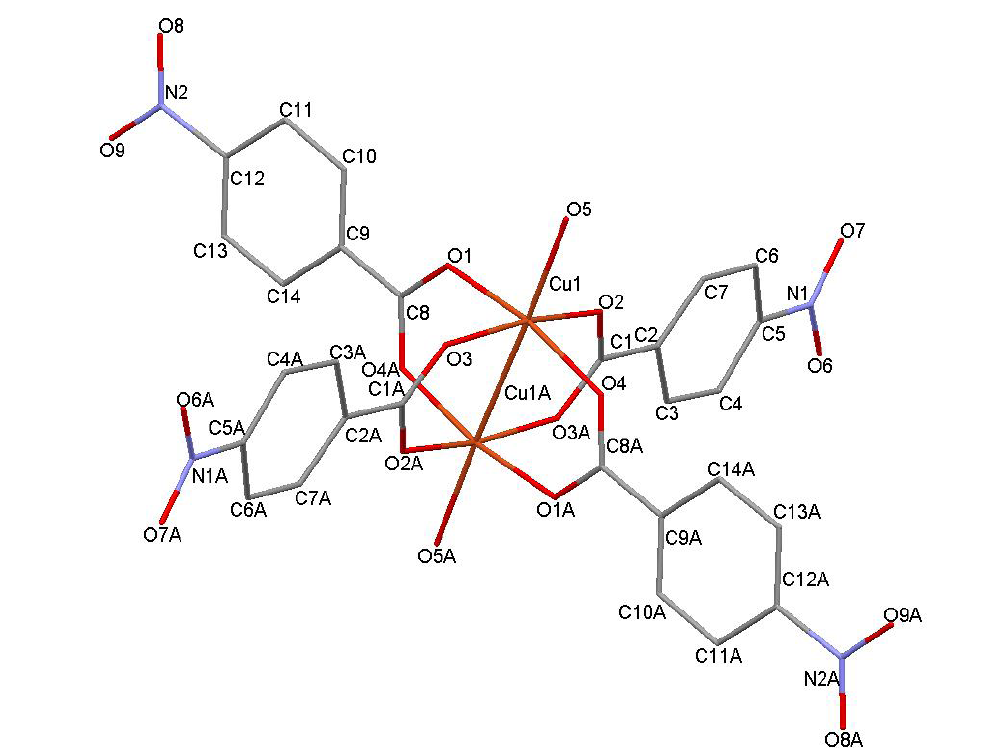
-2-nitrobenzoato-O,O’)-diaqua-di-copper(II) [17]. 2